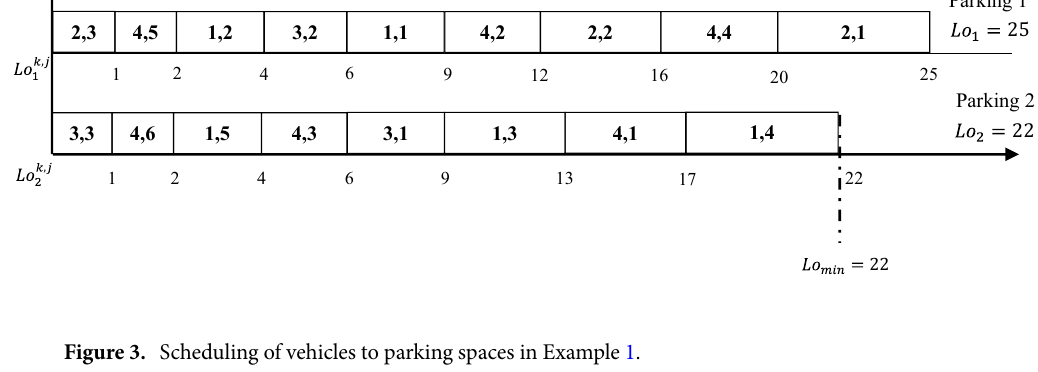
Figure 3. Scheduling of vehicles to parking spaces in Example